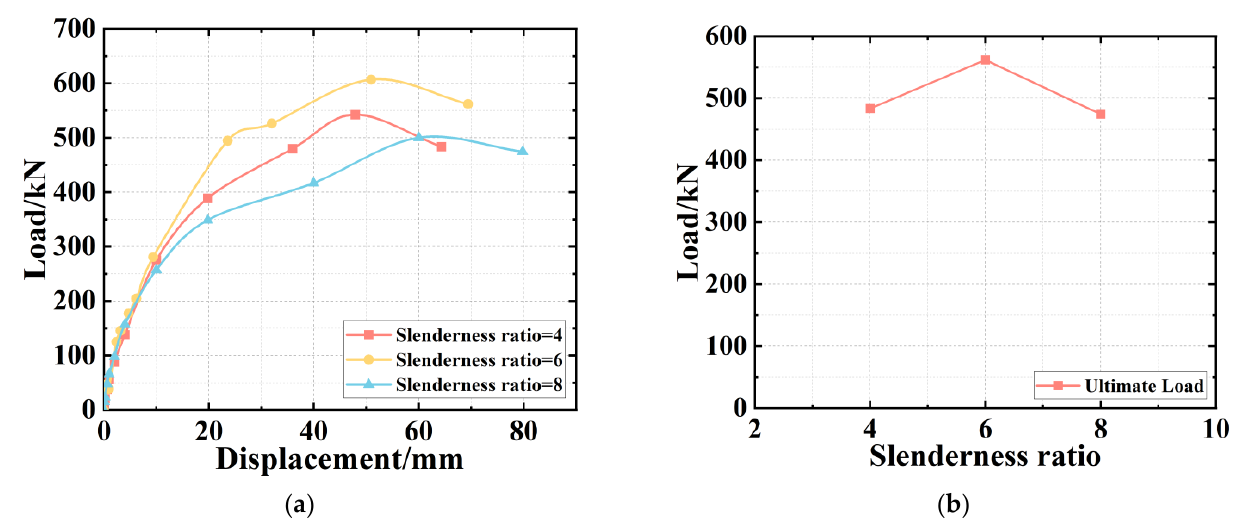
Figure 17. The Simulated Results of Different DWR. ( a ) Load – Displacement Curves. ( b ) The Ulti- mate Load.